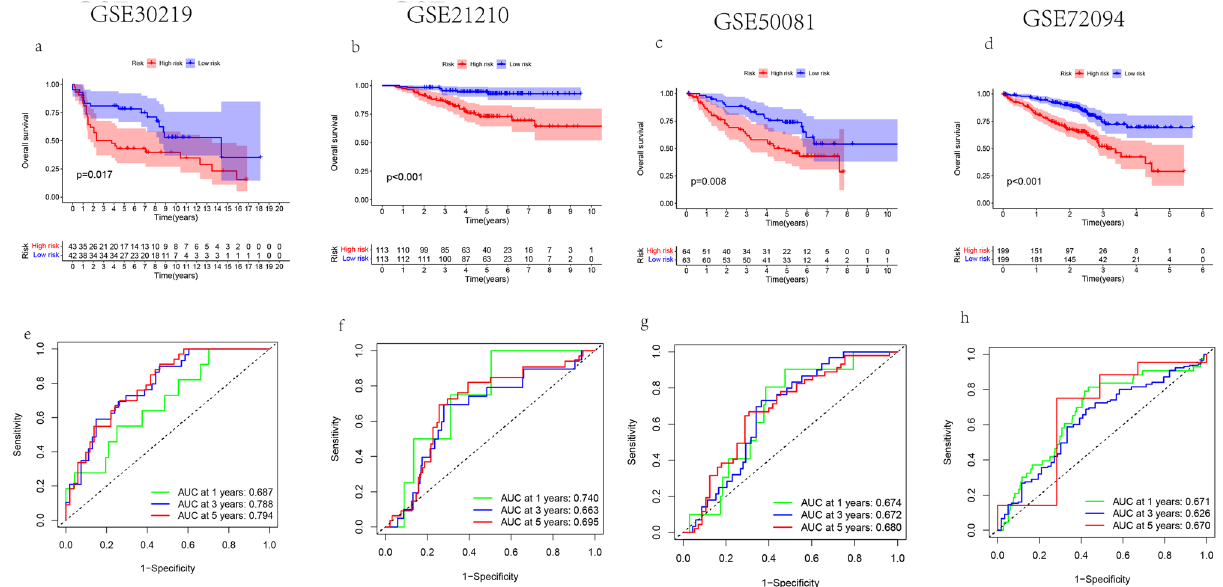
Figure 12. Model validation. ( a – d ) Kaplan Meier OS curve of Gene Expression Omnibus (GEO) datasets. ( e – h ) Receiver operating characteristic (ROC) curve analysis of GEO